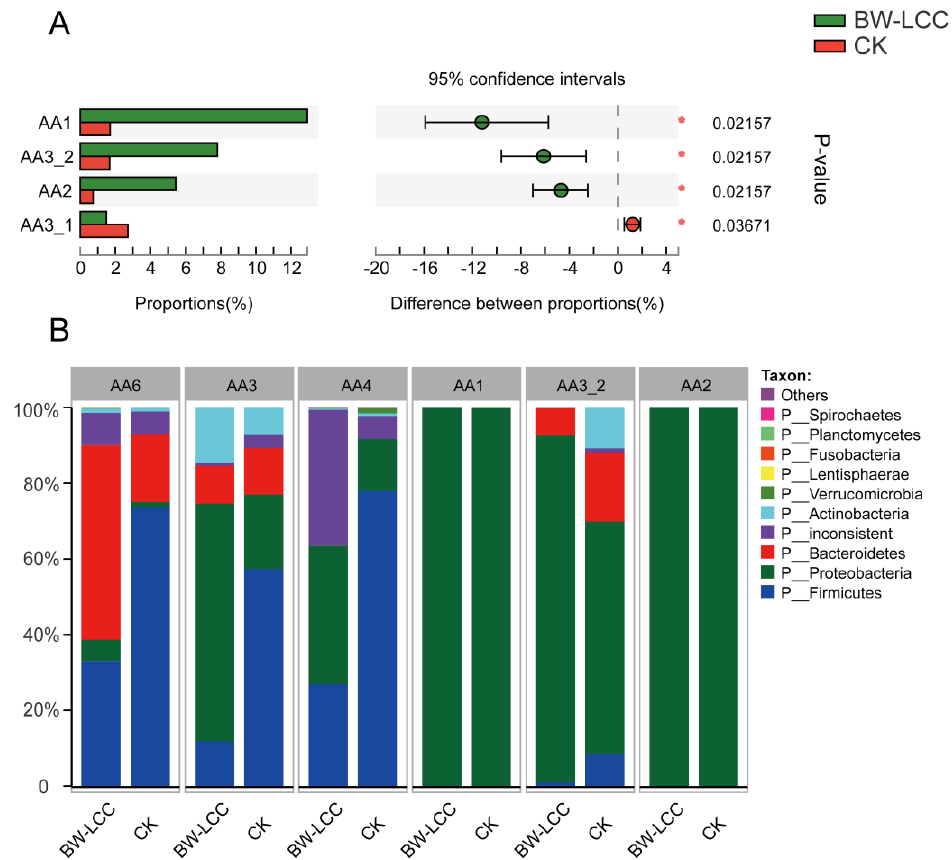
Figure 6. Relative abundance of AAs in gut microbes: ( A ) AAs with significant changes after in vitro fermentation, *, P <0.05; ( B ) species contribution of AAs in gut microbes.